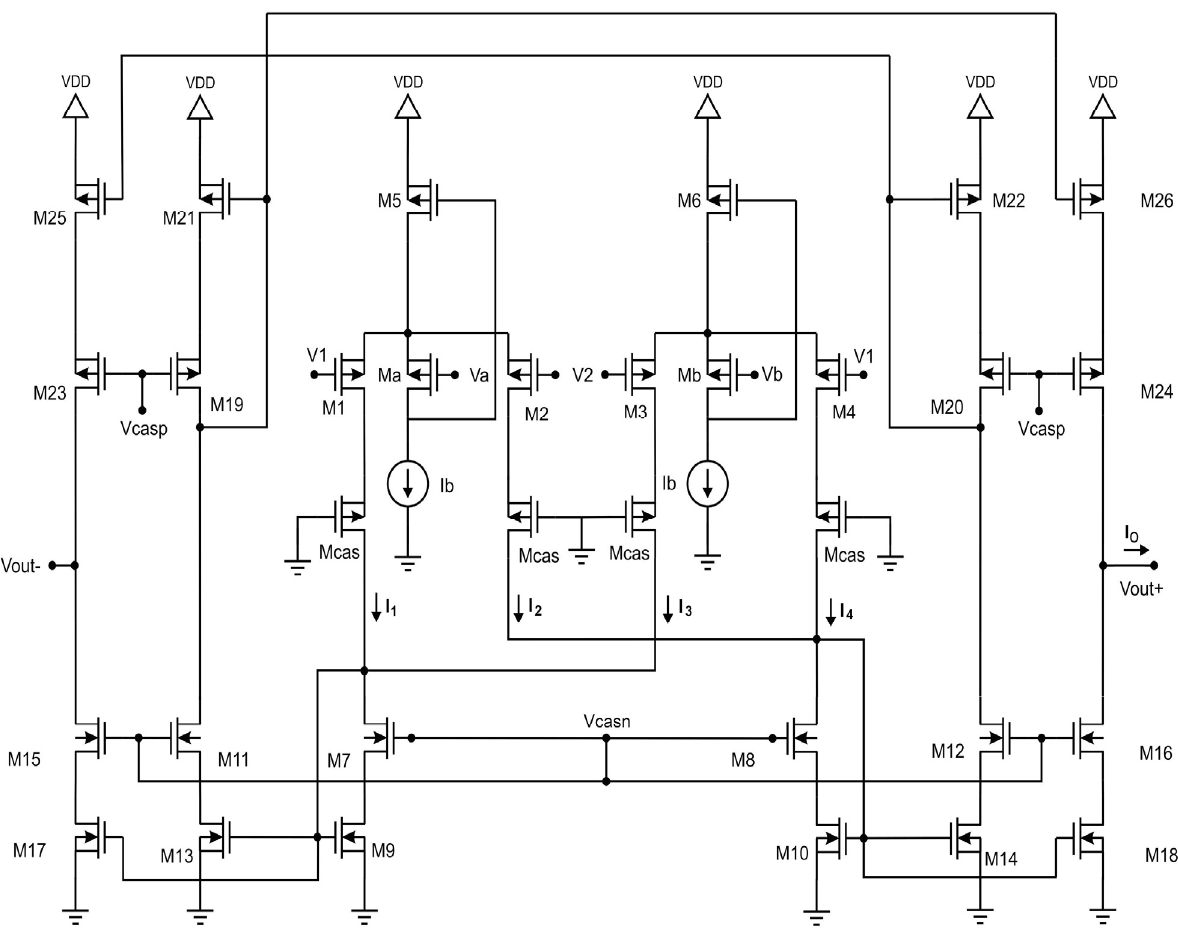
Fig.3: Schematic diagram of the simulated CMOS class-AB operational transconductance amplifier (modified from (40)).